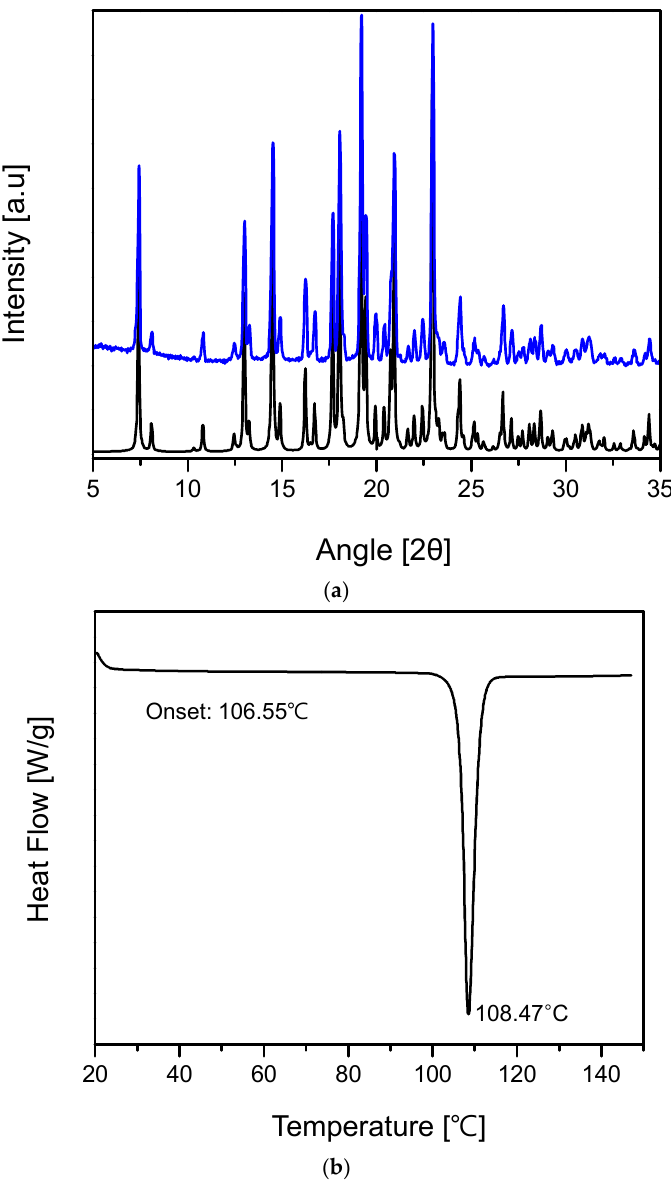
Figure 5. Characterization of TD free base crystal: ( a ) Observed (blue) and simulated (black) powder X-ray diffraction pattern; ( b ) Differential Scanning Calorimetry (DSC) (10 °C/min).